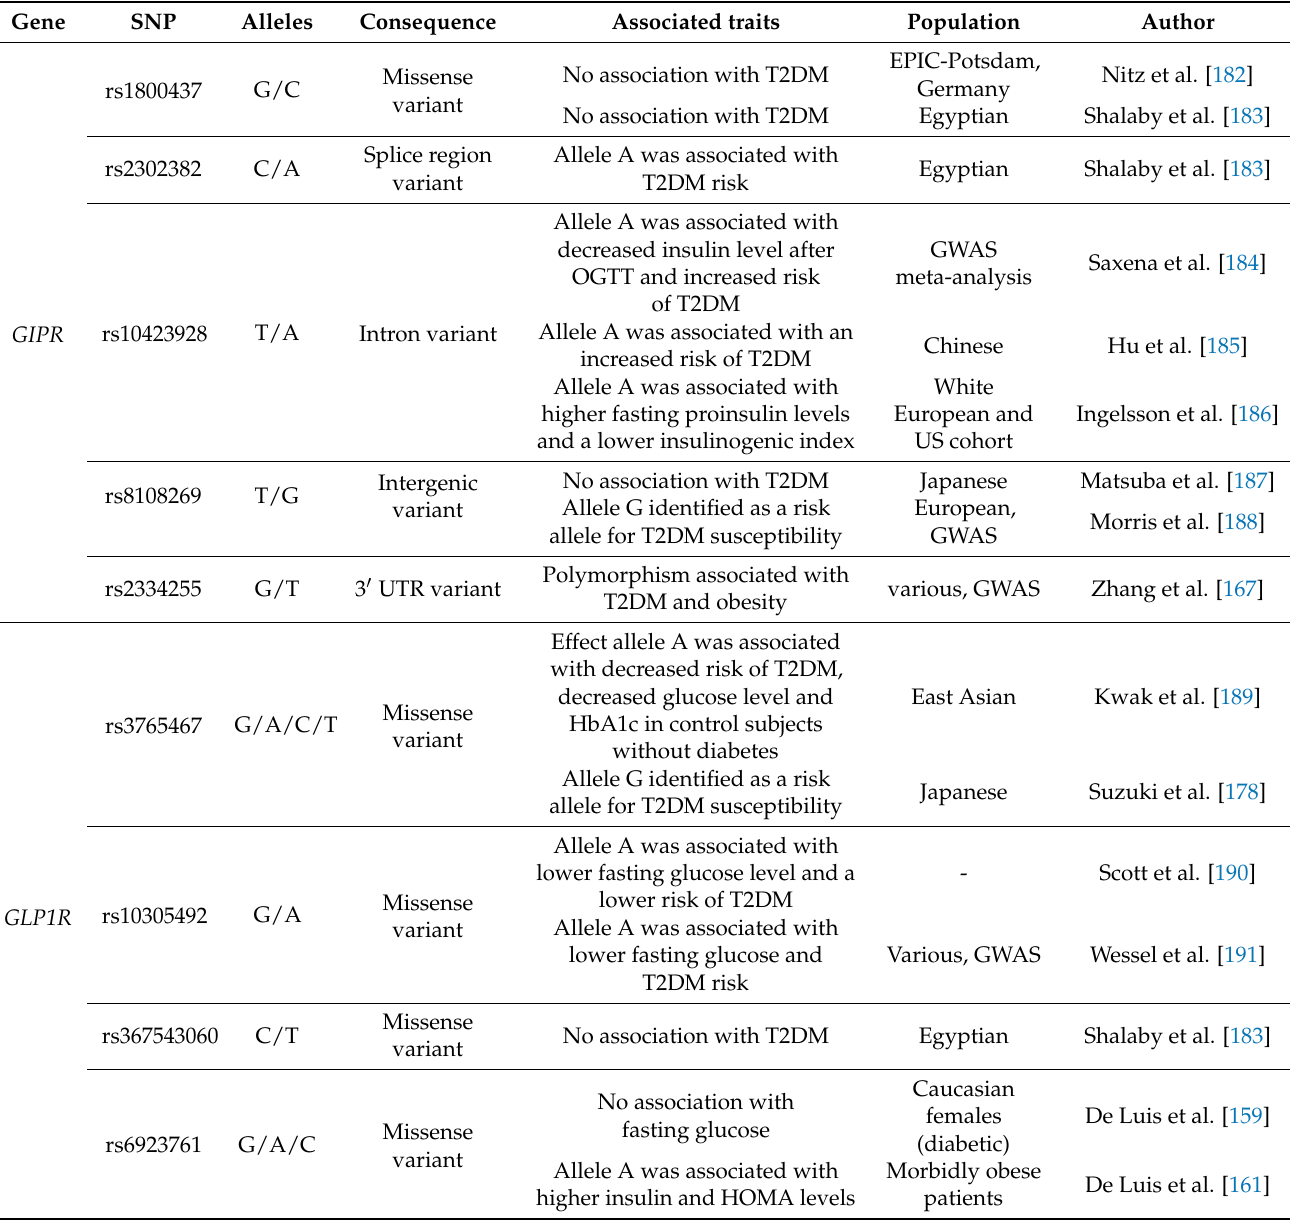
Table 1. Selected variants in GIP and GLP1R and their association with T2DM risk and glucose metabolism. Gene